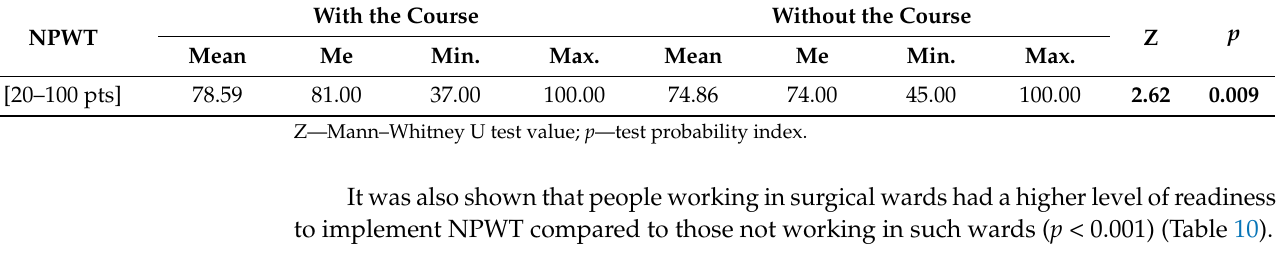
Table 10. Assessment of the relationship between the overall readiness to implement NPWT and work in surgical. Work in Surgical NPWT